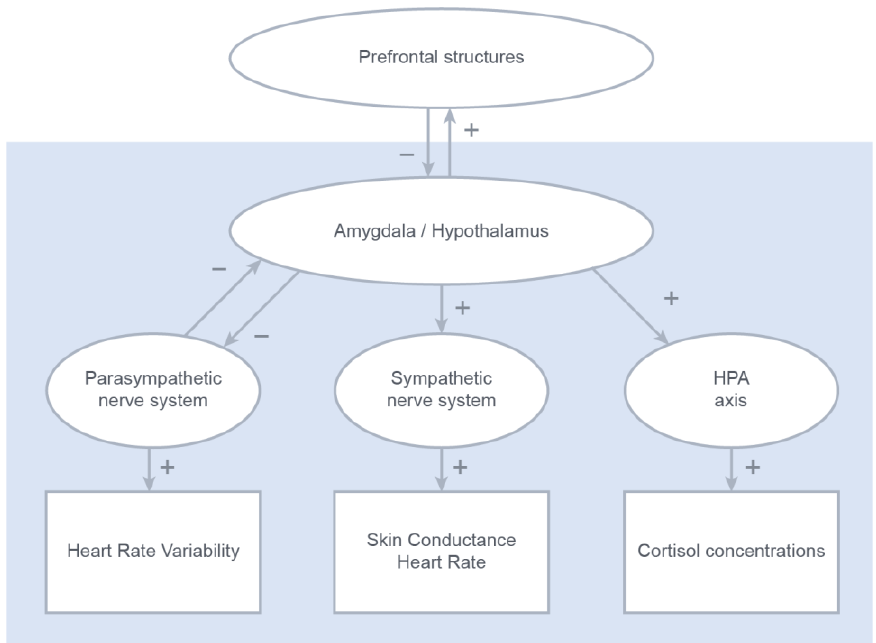
Figure 1. A schematic overview of the inhibitory and excitatory influences of multiple-layer neurological structures orchestrating the peripheral stress responses.